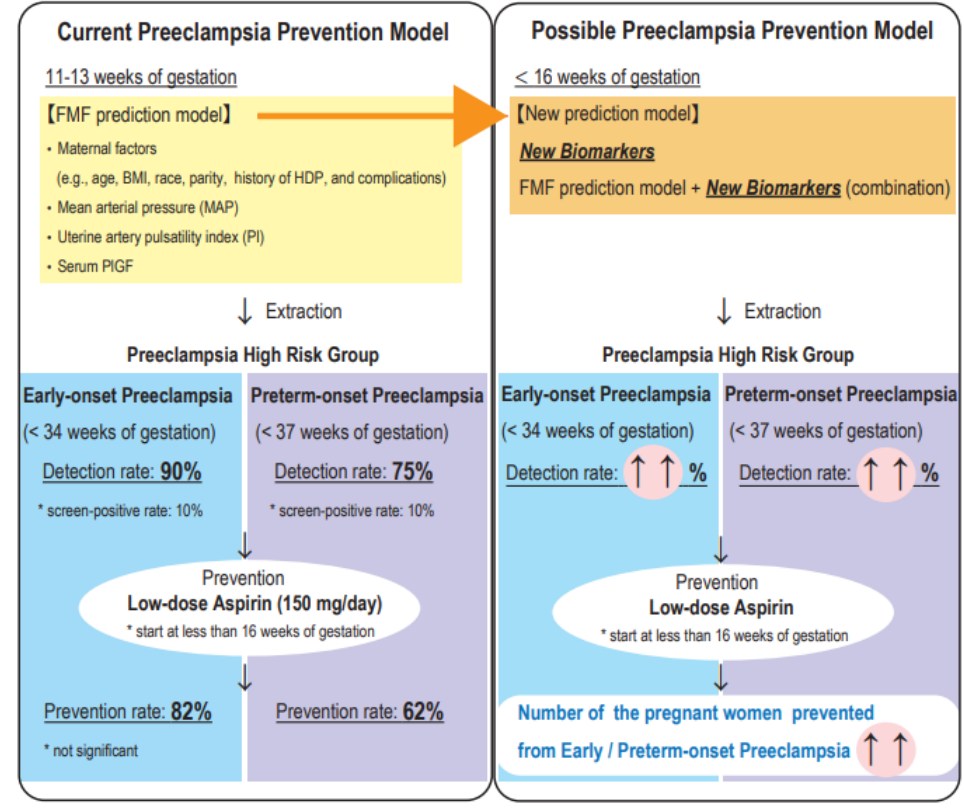
Figure 1. Current and possible prevention models for preeclampsia. The current model, validated by the ASPRE trial, uses a combination of maternal characteristics and mean maternal arterial pressure, the uterine artery pulsatility index, and maternal serum PlGF at 11–13 weeks of gestation to identify pregnant women at high risk of preterm onset preeclampsia (POPE). A low oral dose aspirin (150 mg/day) for these women before 16 weeks of gestation reduced POPE by 62% (significant) and early onset preeclampsia by 82% (not significant). In this model, the detection rate of POPE high-risk pregnant women was 75%, and increasing this sensitivity is our challenge. New biomarkers that extract POPE or EOPE high-risk pregnant women with high sensitivity before 16 weeks of gestation are desired.